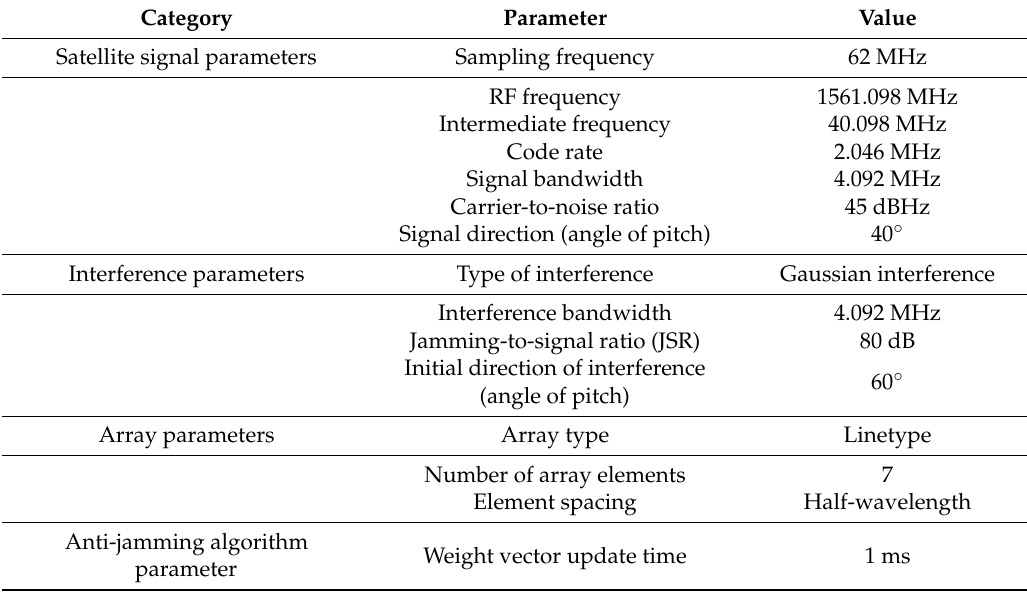
Table 1. Simulation parameter